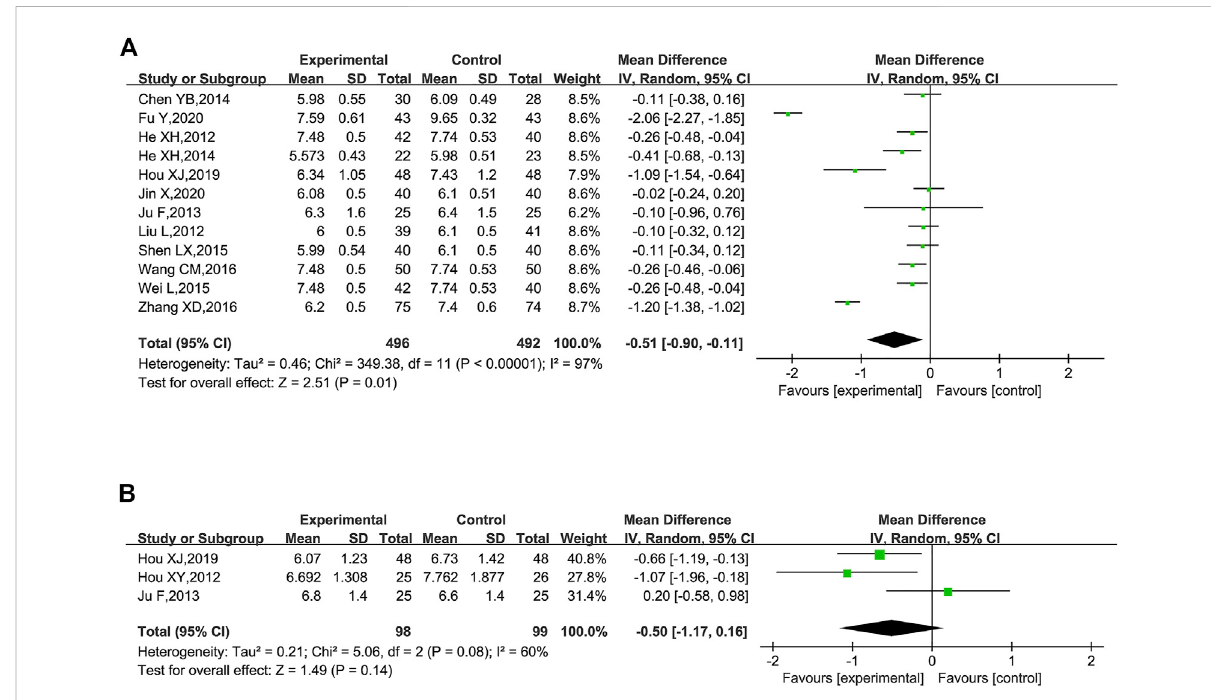
FIGURE 9 Forest plot of glucose for KLXC + Western medicine vs. Western medicine alone. (A) Forest plot of FBG for KLXC + Western medicine vs. Western medicine alone. (B) Forest plot of HbA1c for KLXC + Western medicine vs. Western medicine alone.